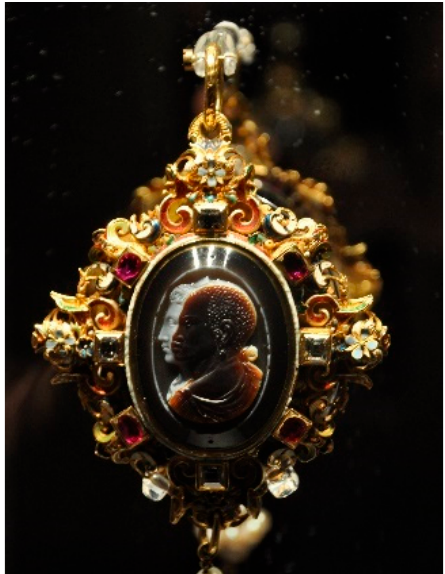
Figure 8. The Drake Jewel given to Sir Francis Drake by Elizabeth I probably in the year 1586. Victoria and Albert Museum via Wikimedia. https://commons.wikimedia.org/wiki/File:Drake_Juwel.JPG. Accessed on 10 June